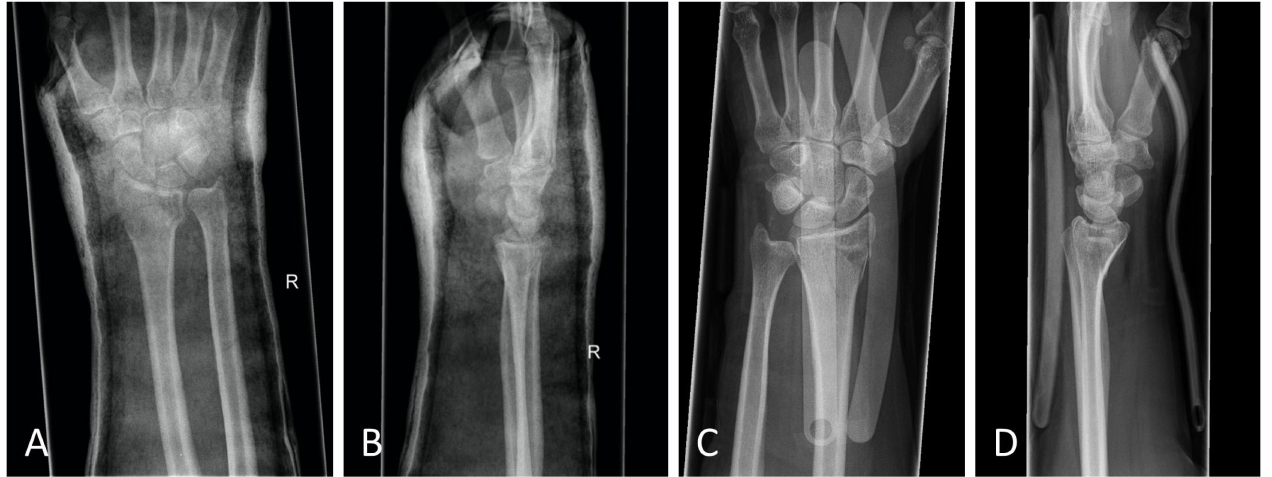
Figure 6. ( A ) Posteroanterior radiograph with cast. ( B ) Mediolateral radiograph with cast. ( C ) Posteroanterior radiograph with orthosis. ( D ) Mediolateral radiograph with orthosis. All radio- graphs were taken after reduction before surgery.